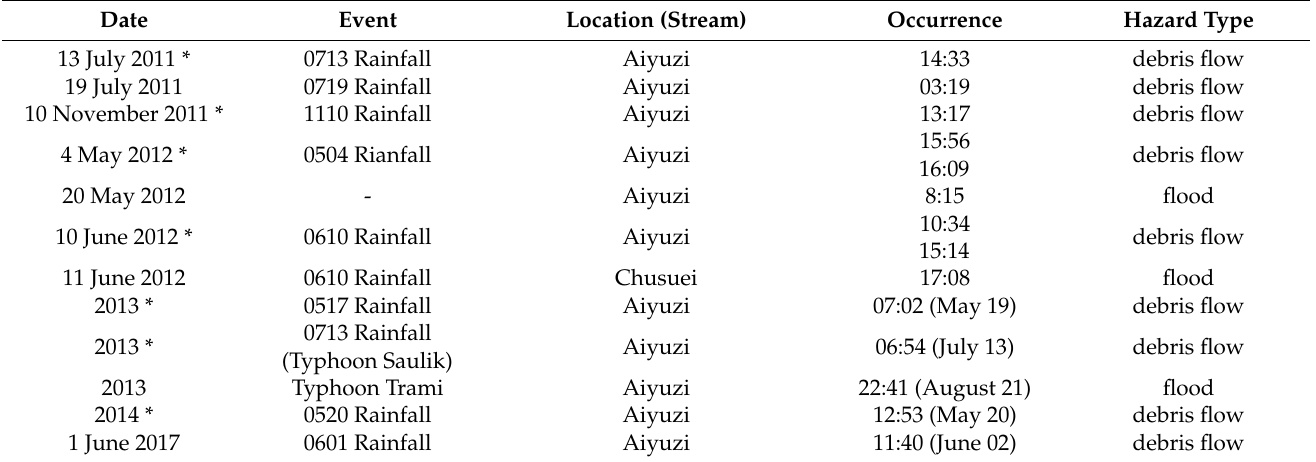
Table 3. Cont. Figure 2. The layout of monitoring devices in the Shenmu area. Table 3. Debris flow hazard history of Shenmu [24]. Table 2. Specification of geophone OYO Geospace GS-20DX [22].